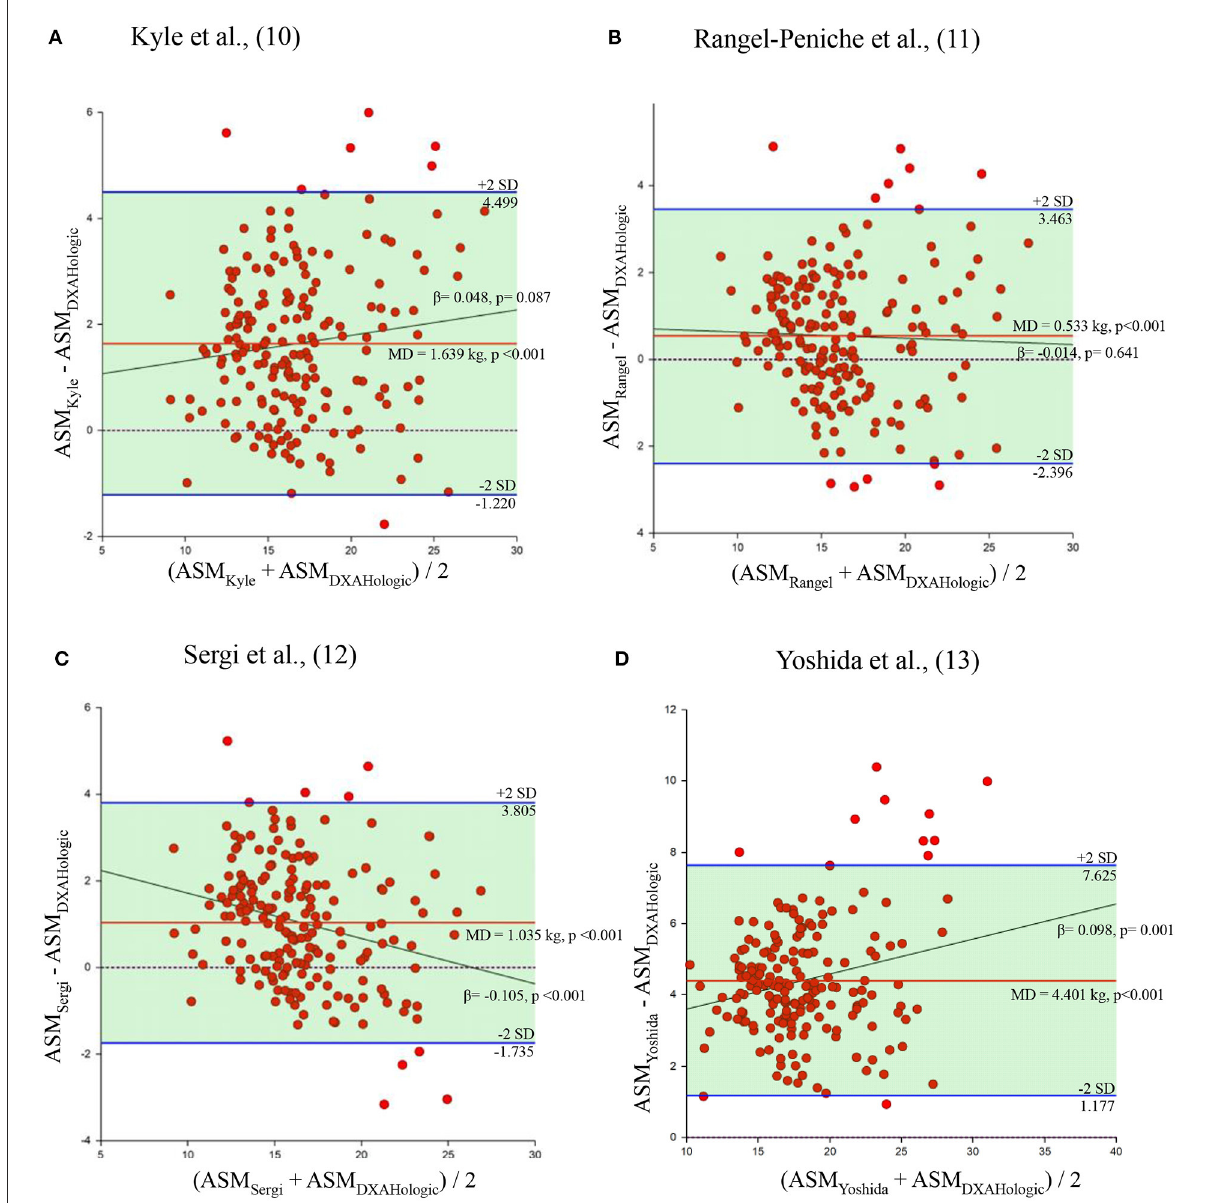
FIGURE2 Bland and Altman plots of the equations generated using DXA Hologic. Behavior of the mean difference against the mean of the measurements between the equations of Kyle et al., (10), Rangel-Peniche et al., (11), Sergi et al., (12) and Yoshida et al., (13), and DXA Hologic. Solid red lines indicate the mean difference. Solid blue lines indicate limits of agreement. Solid black lines indicate the regression line. Dotted line indicates zero. ASM, appendicular skeletal muscle mass; MD, mean of the differences. (A) Kyle et al. (10). (B) Rangel-Peniche et al. (11). (C) Sergi et al. (12). (D) Yoshida et al.